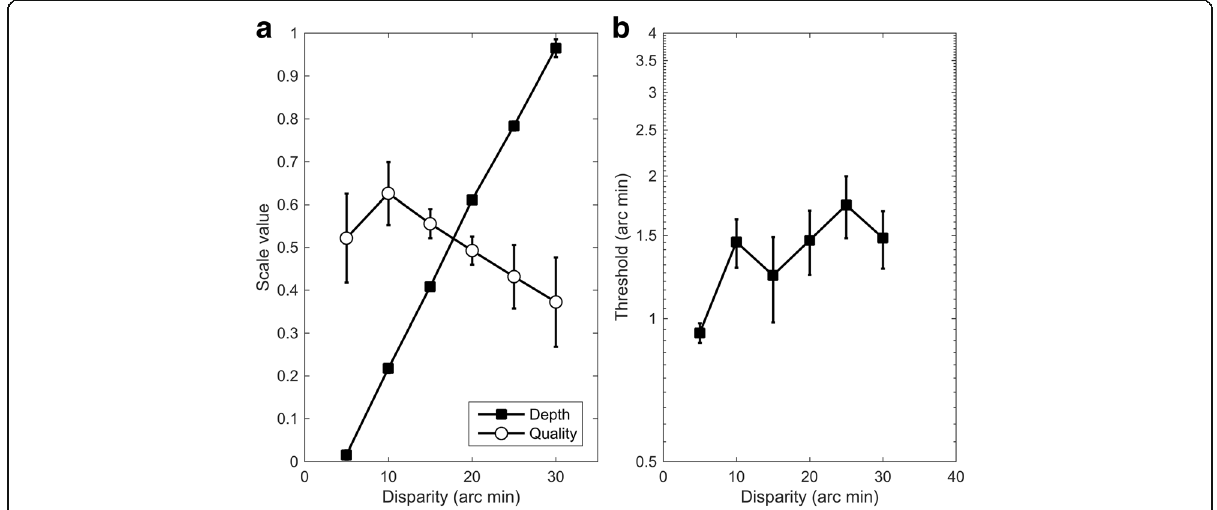
Fig. 4 a Depth magnitude and quality values and ( b ) depth discrimination thresholds for experiment 3, in which a smaller range of disparities was used. Data plot the mean over ten participants; error bars show ±1 standard